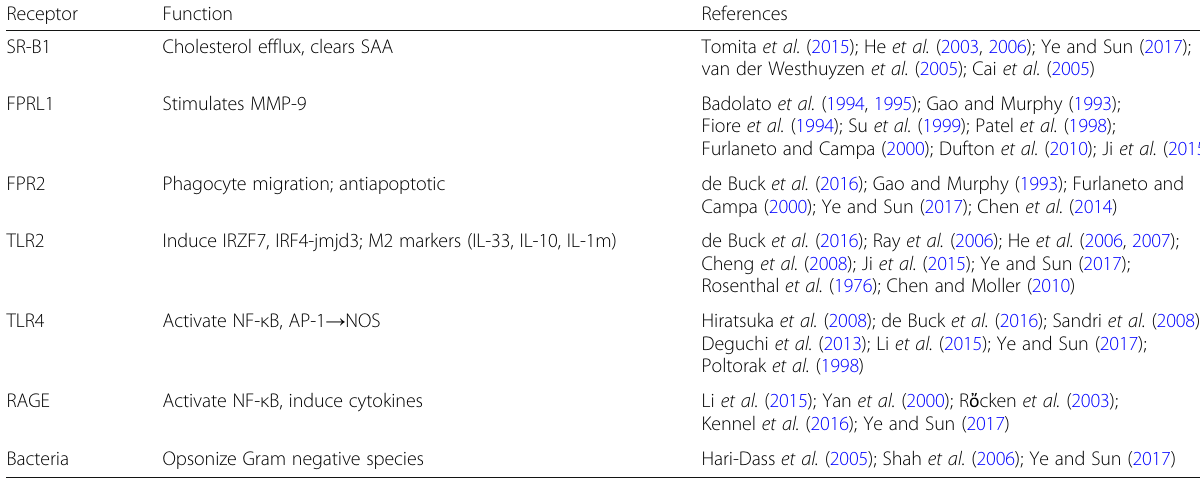
Table 1 SAA receptor interactions